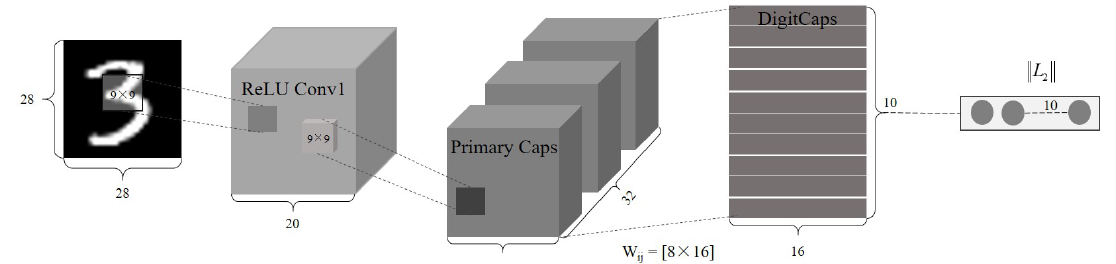
Figure 1. Architecture of a capsule network with 3